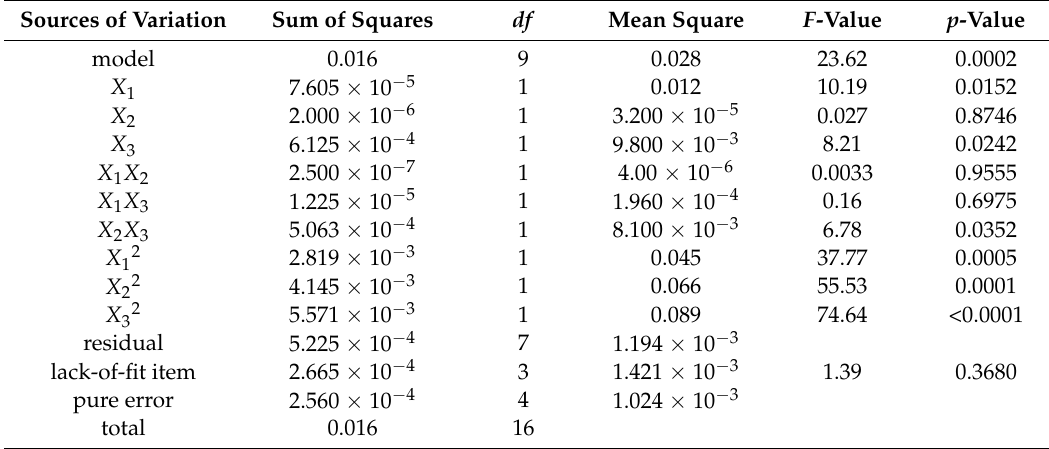
Table 2. Variance analysis of items in the regression